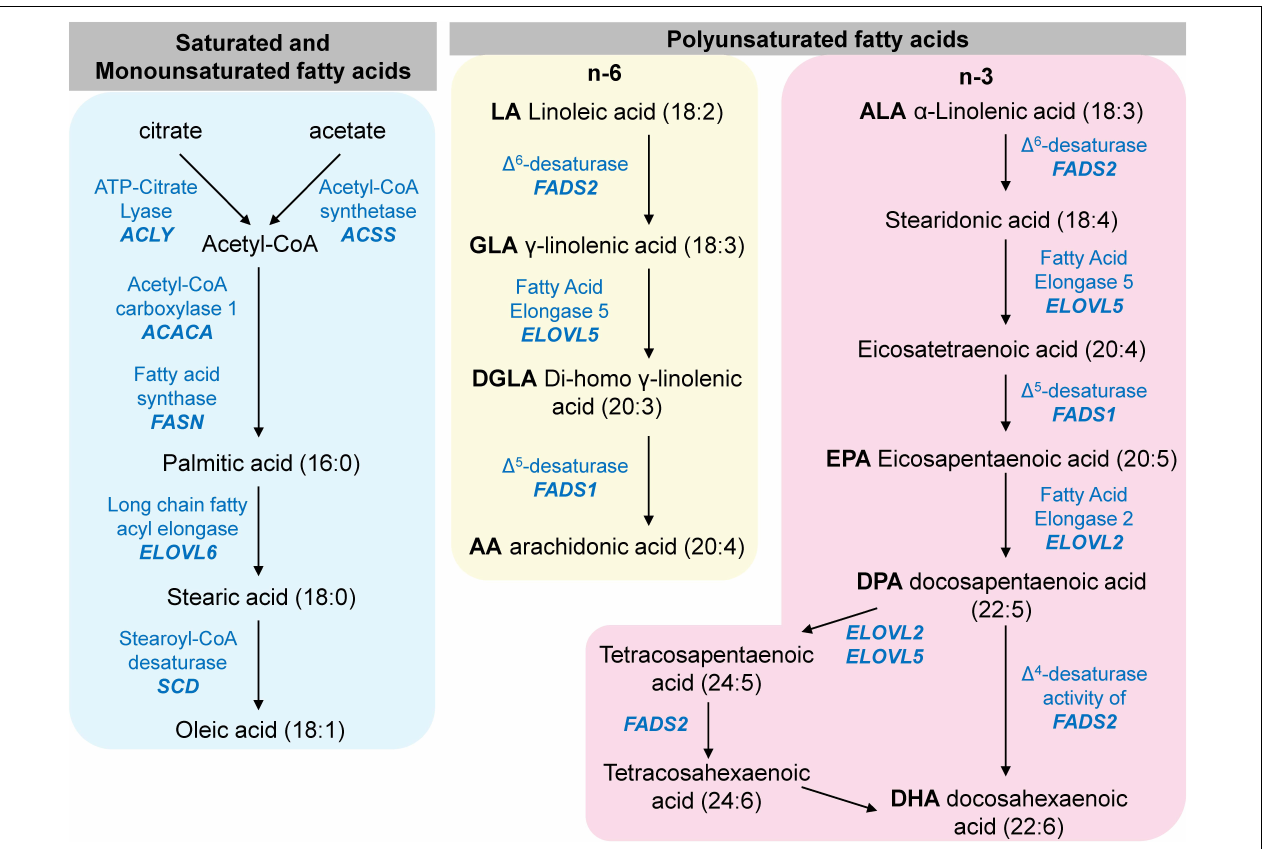
FIGURE 10 | A simplified diagram of mammalian fatty acid metabolism. The enzymes listed in this diagram are encoded by genes that are transcriptionally regulated by SREBP.